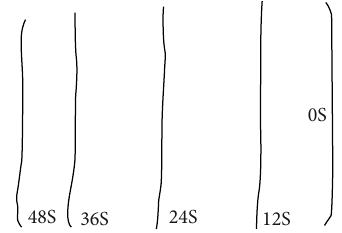
Figure 7: Imaging of grain end at each di ff erent moment of Test3.